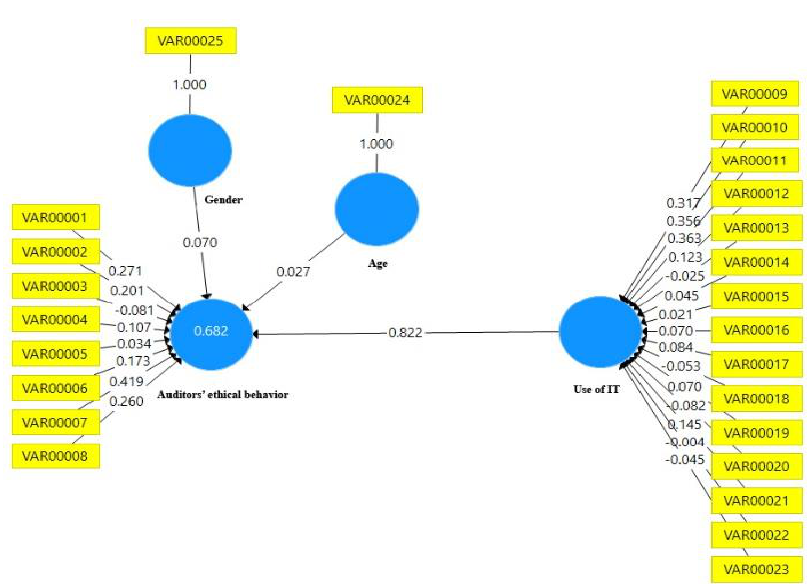
Fig. 3. T-value statistics of the general research model with the bootstrap